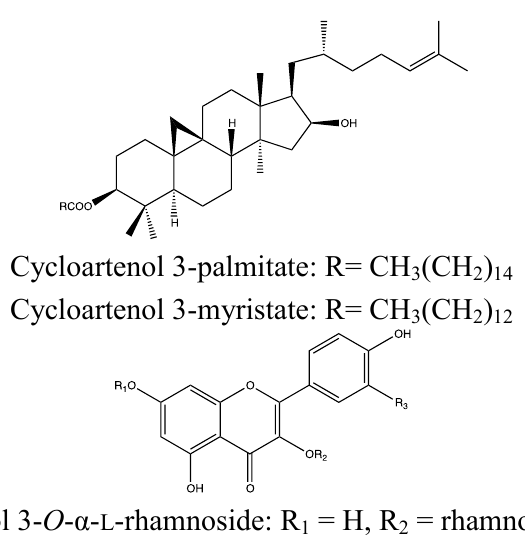
= H, R = rhamnose, R = H 1 2 3 = rhamnose, R = H, R = H 1 2 3 = R = rhamnose, R = H 1 2 3 = H, R = rhamnose, R = OH 1 2 3